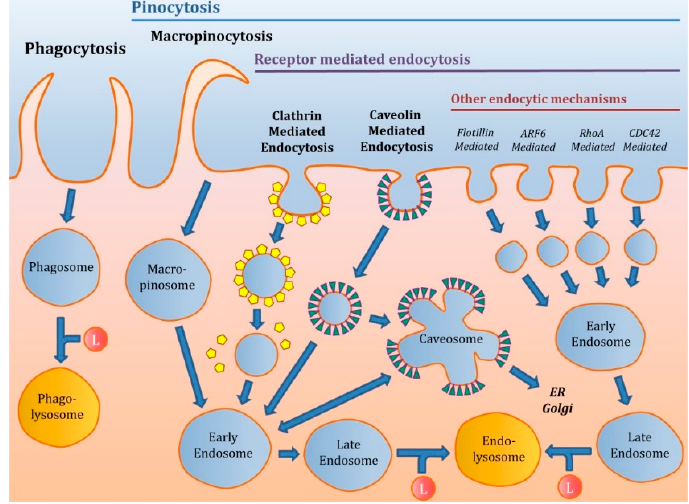
Figure 1. Main energy-dependent uptake pathways of the cell. Macropinocytosis forms macropinosomes that could finally join the early endosomes. Clathrin-mediated endocytosis (CME) and caveolin mediated endocytosis (CVME) are the main receptor-mediated endocytosis (RME) processes. On the other hand, other endocytic RME mechanisms as flotillin, ARF6, RhoA, or CDC42 mediated endocytosis are also present in the cell. The final fate of endosome vesicles is to fuse with lysosomes.